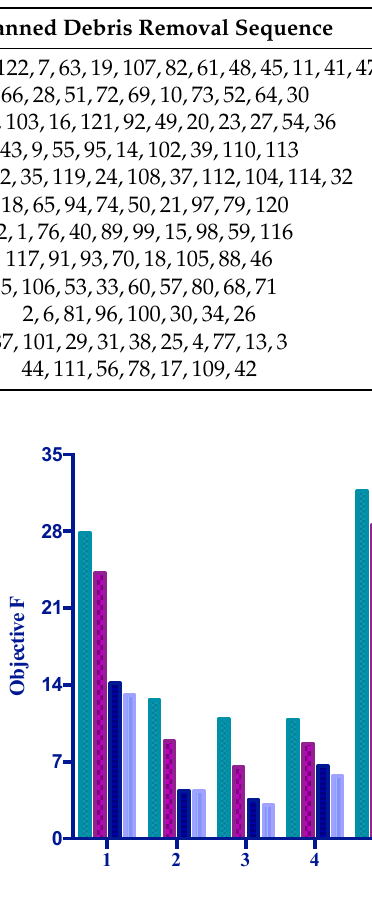
Figure 9. Comparison of the optimal replanned debris removal plan for MIGA, ACO, GH, and the Ptr-nets+AC